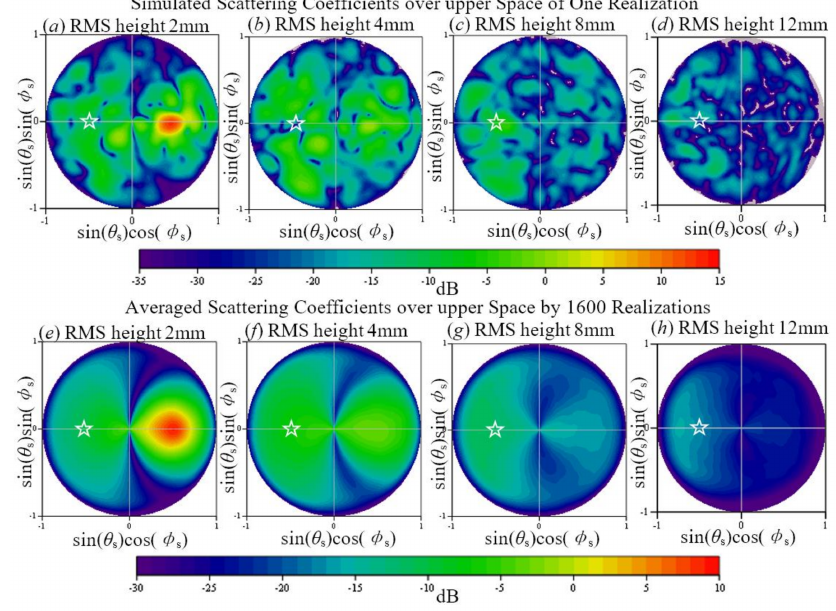
Figure 15. Results of simulated bi-static scattering coefficients over the upper space, considering different RMS height ( h ). The backscattering angular position is marked by the white-lined star. Sample and computation parameters are in Tables 1 and 3(set